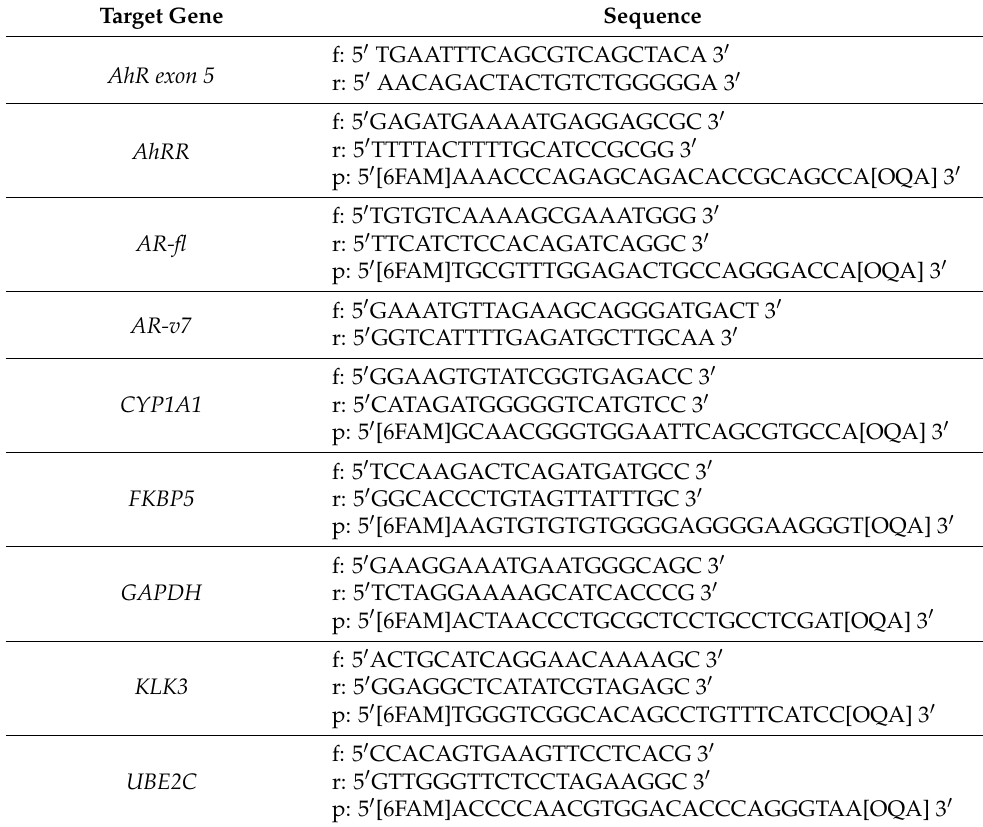
Table 4. Sequences of used primers and